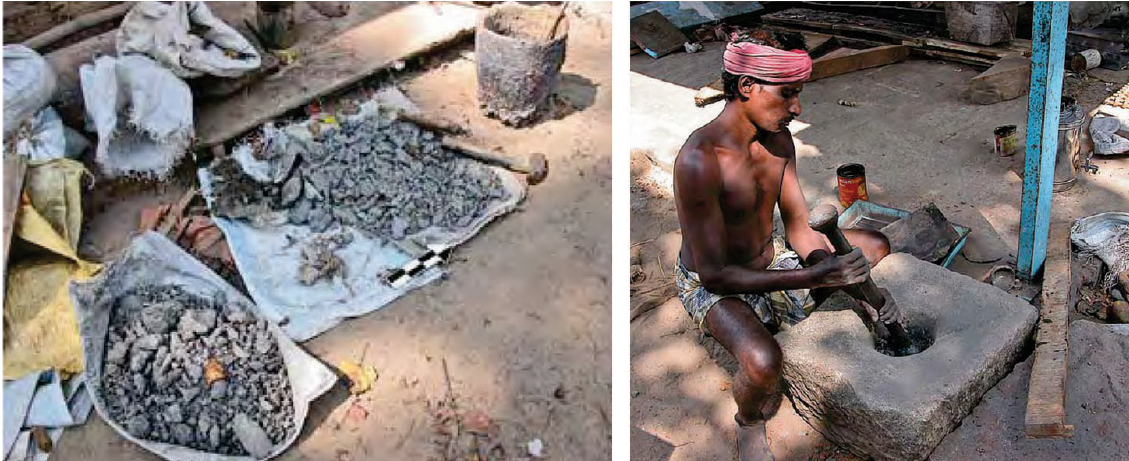
Figure 16. Metal recycling in a Swamimalai workshop: slag and metal bits collected from crucibles and sediment from the floor of the workshop (left) are pounded and crushed in stone mortars (right; Source: Levy et al. 2008b).